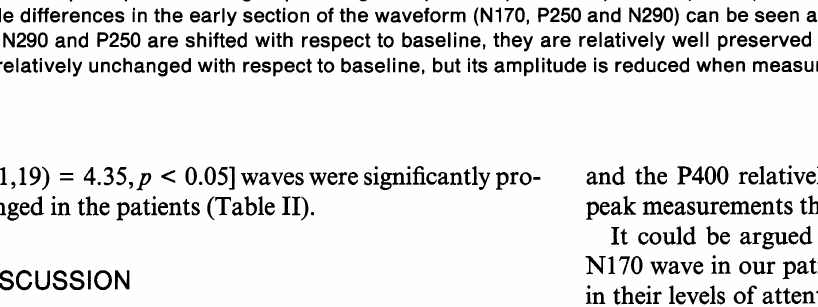
F(1,19) = 4.35,p < 0.05] waves were significantly